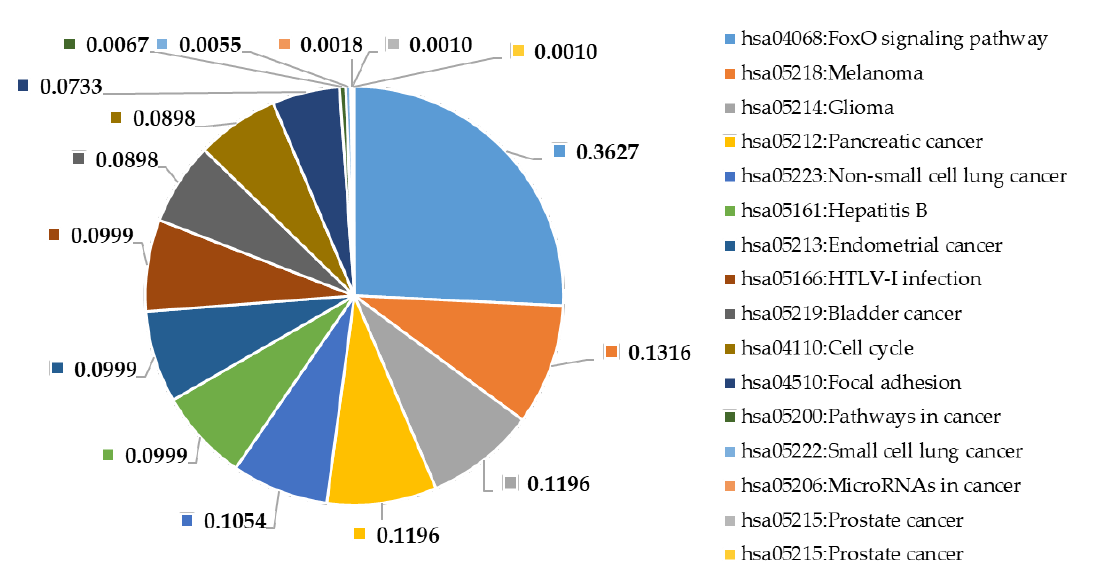
Figure 6. Functional annotation enrichment of target genes of the 38 most deregulated miRNAs based on their enrichment in specific Kyoto Encyclopedia of Genes and Genomes (KEGG) pathways. Significance of the selected (?) pathways are characterized by their FDR values shown inside the chart sections.